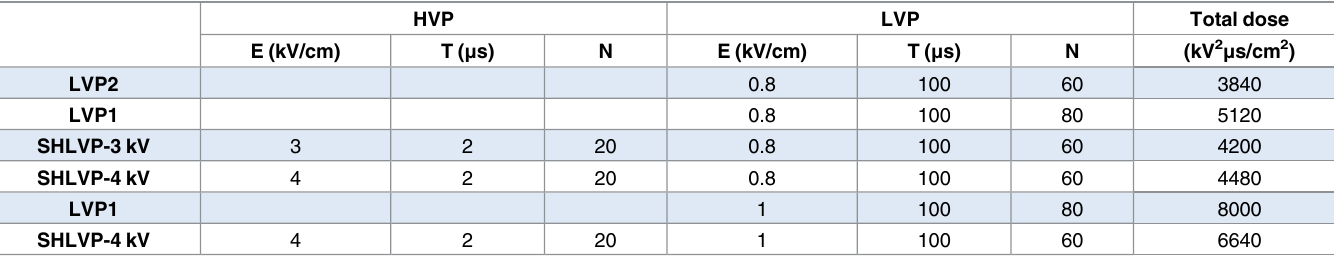
The voltage and current were monitored in real time with a LeCroy oscilloscope (Wave- Pro760Zi-A, bandwidth: 6 GHz, USA) and a 411 Pearson current probe (Pearson Electronics Inc., Palo Alto, USA); the voltage and current waveforms were synchronous (Fig 1C). The energy injected through electric pulsation is given by the following equation: Z t W ¼ UIdt ð 2 Þ 0 where U is the voltage of the pulse, and I is the current of the pulse. Table 3. Schemes for pulsation protocols with different